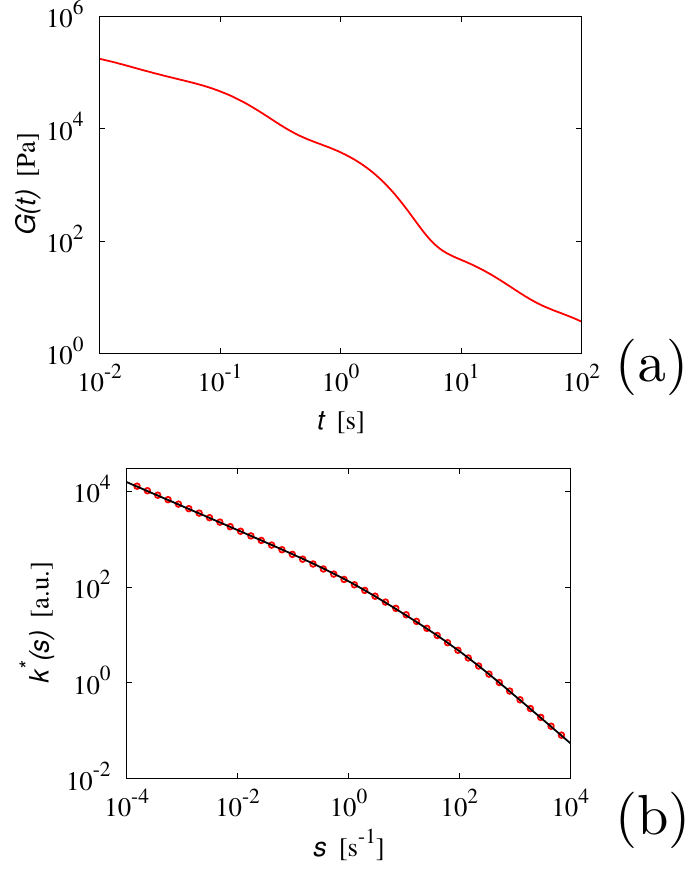
Figure 3. Panel ( a ) G ( t ) vs t for polydimethilsiloxane at T = 25 ◦ C. Panel ( b ) (symbols) k ∗ ( s ) = (cid:98) k ( s ) / α vs s for the same fluid, obtained from Equation (54). The solid line is the approximation of these data using N i = 2, prototypical visco-inertial modes, as discussed in the main text.